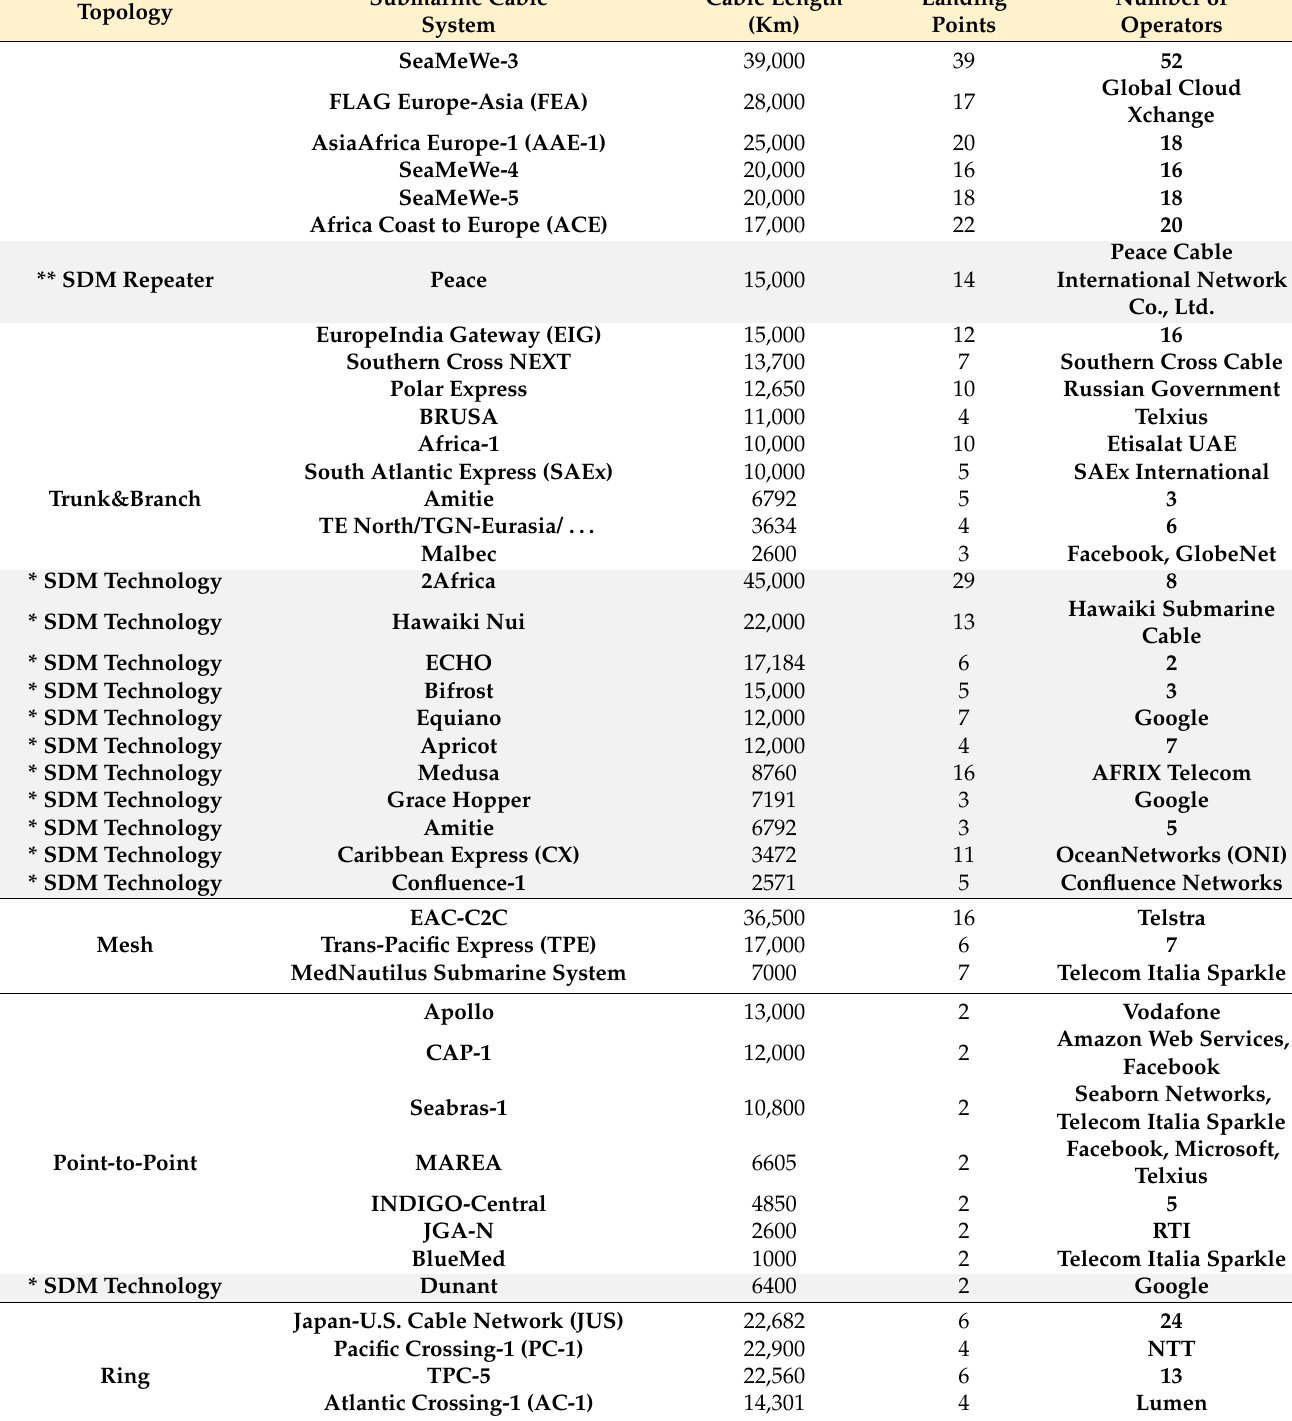
Table 5. A taxonomy of existing submarine cable systems based on their topology